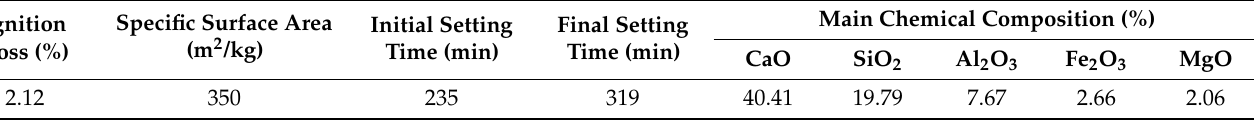
Table 2. Physical properties and main chemical composition of cement.